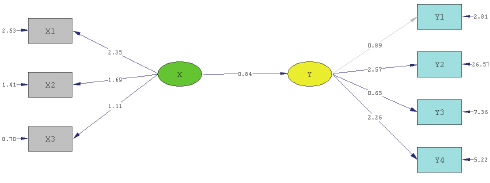
Fig. 3. Std. Coefficient Strategic Planning for Competitive Advantages of